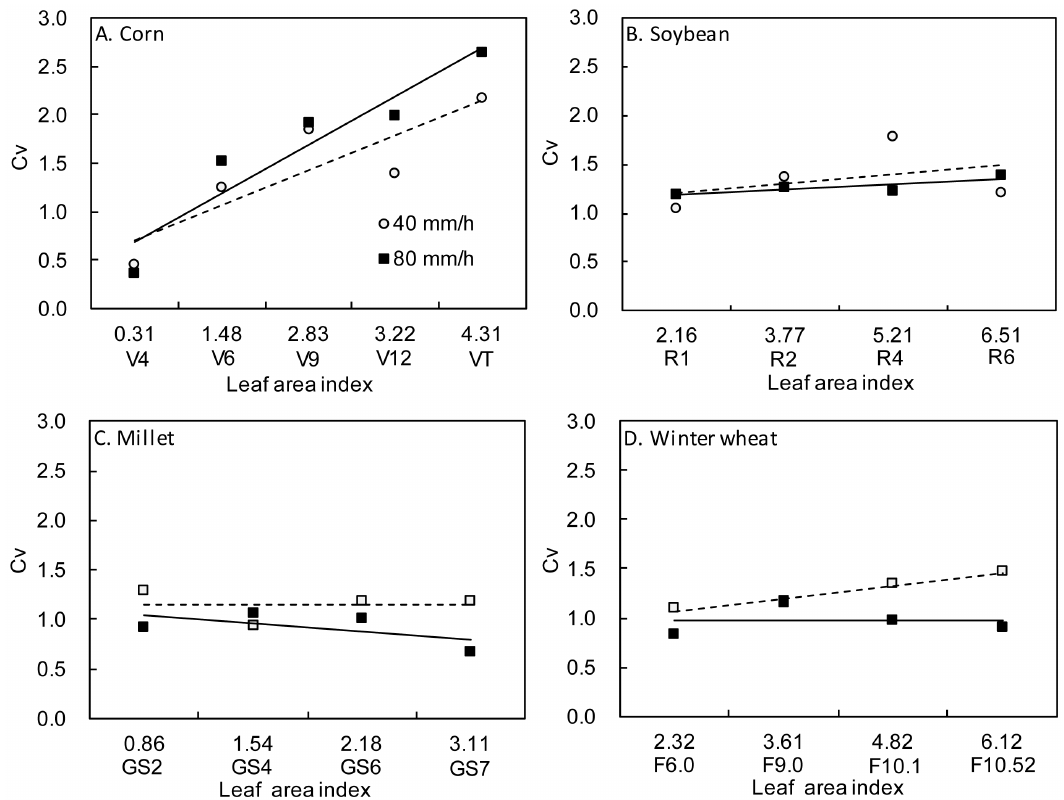
Figure 4. Relationship between Cv of splash detachment and crop growth.